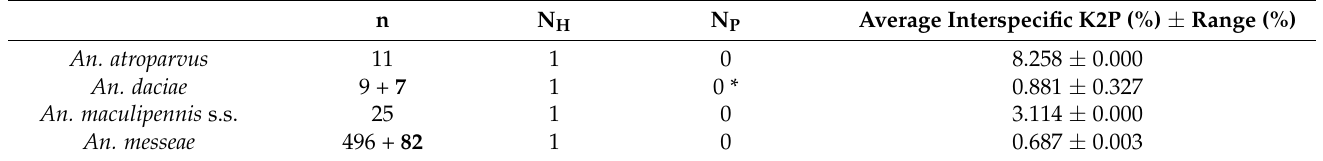
Table 1. Descriptive statistics of the genetic diversity of ITS2 within Anopheles maculipennis s.l. in the Netherlands, including the average interspecific K2P distances among sequences (excluding conspecific identical sequences).